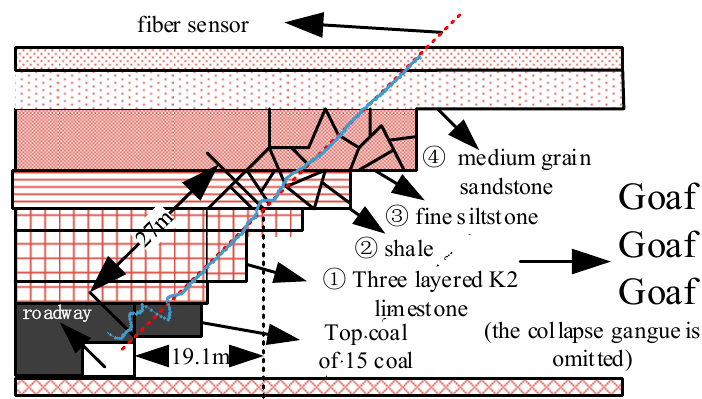
Figure 28. Schematic diagram of rock formation deformation on the fiber-optic section on 7 September.